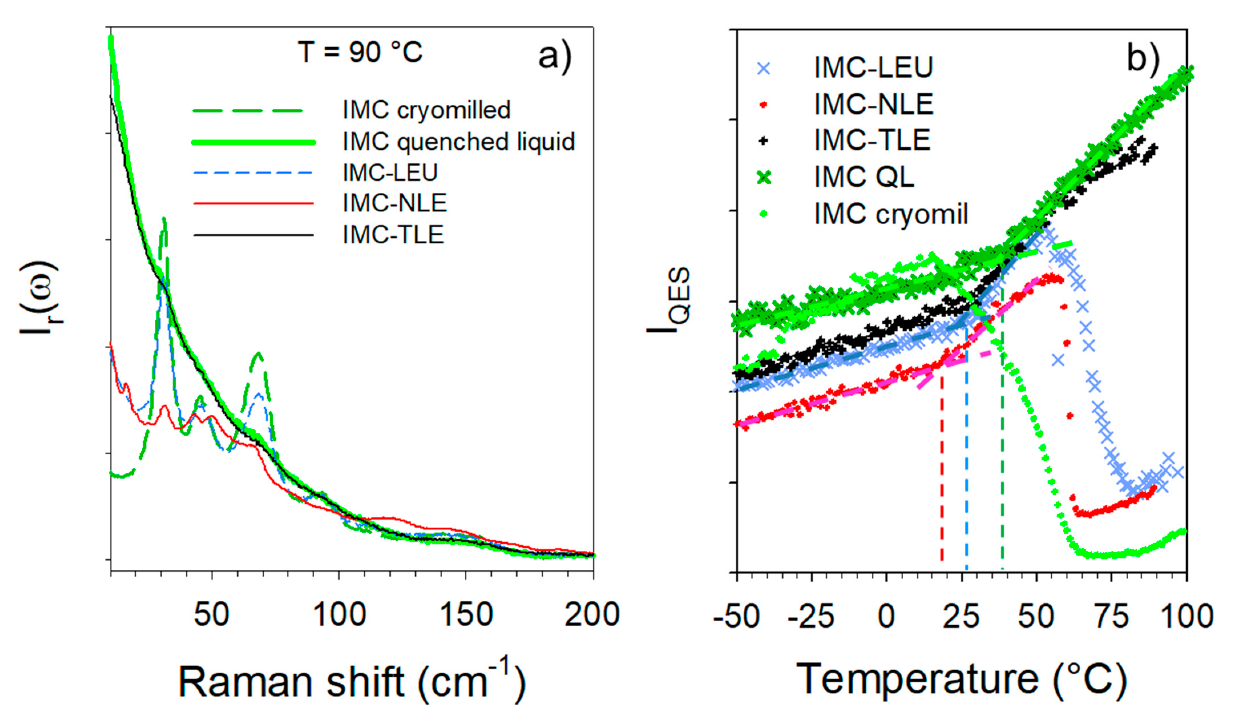
Figure 5 . Analysis of the LFRS of the IMC–AA blends. ( a ) Spectra collected at 90 °C; ( b ) temperature Figure 5. Analysis of the LFRS of the IMC–AA blends. ( a ) Spectra collected at 90 ◦ C; ( b ) temperature dependence of the QES . dependence of the QES.